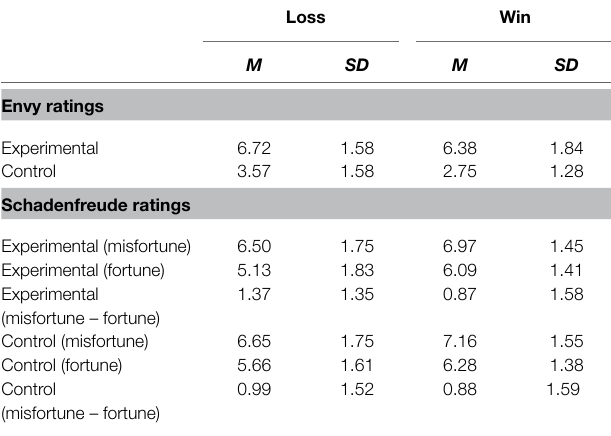
TABLE 1 | Mean ratings of envy and schadenfreude and the SDs for all experimental conditions in Experiment 1. Loss Win M SD M SD Envy ratings